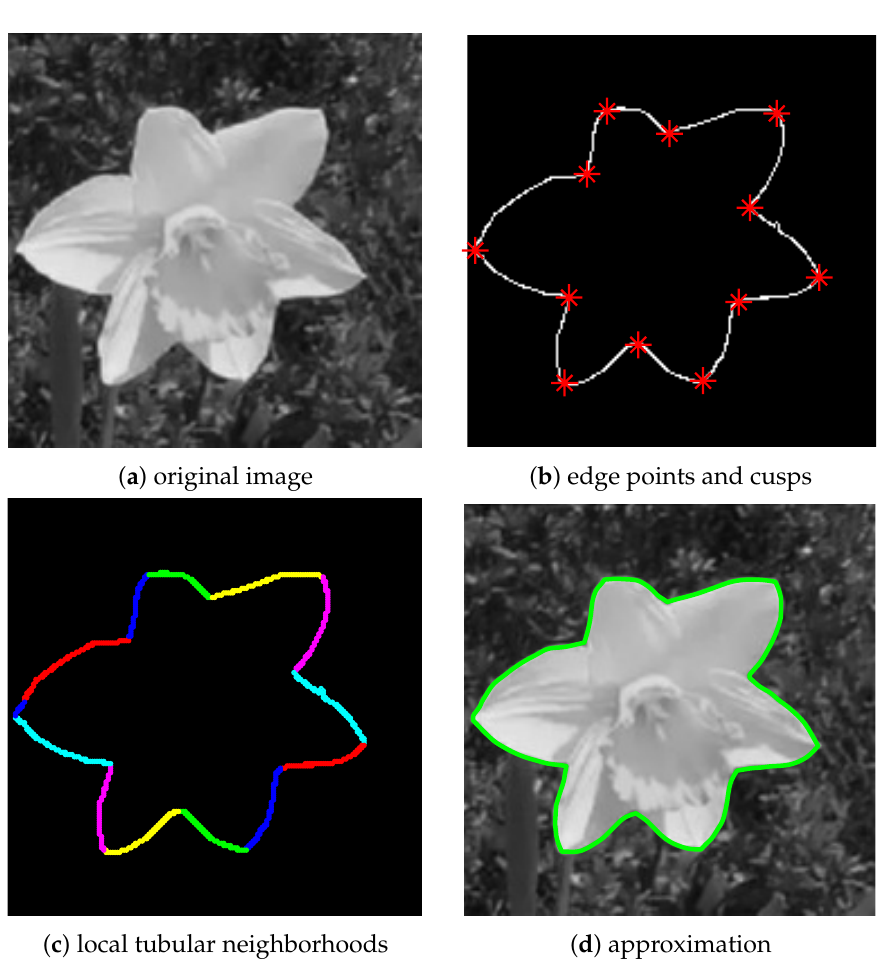
Figure 6. Recognition and approximation of a daffodil. The input image ( a ) is pre-processed to obtain the edge points and detect the cusps ( b ). The point cloud is then split into local segments, see ( c ). The approximated curve, superimposed to the original image, is given in ( d ).